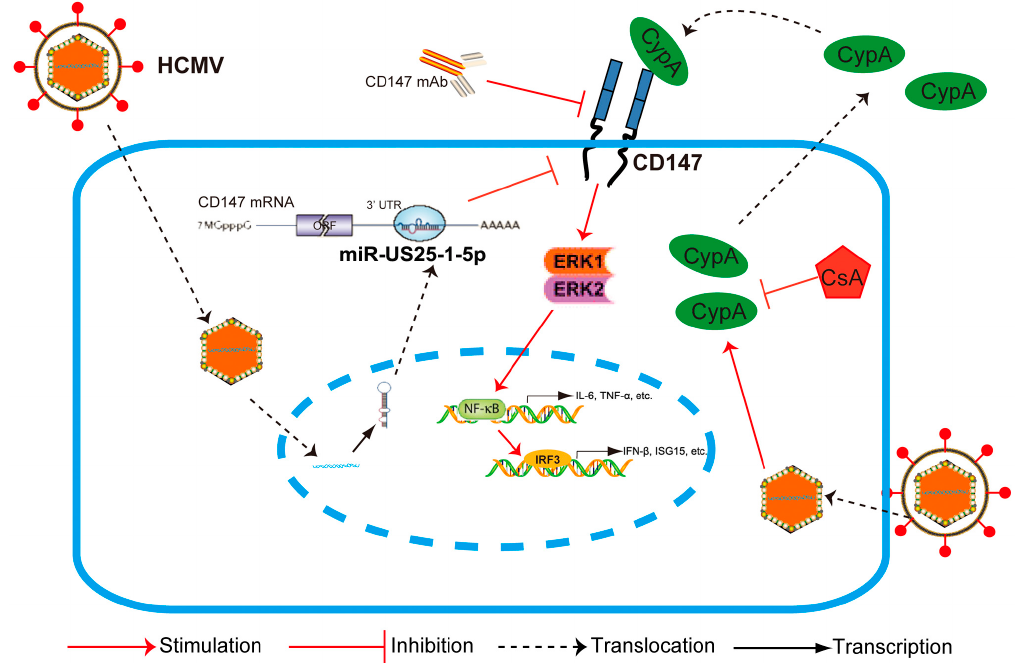
Figure 6. General model for HCMV miR-US25-1-5p in attenuating CD147/EMMPRIN-mediated HCMV-triggered early antiviral response. Upon HCMV infection, intracellular CypA is released. As a paracrine proinflammatory cytokine, CyPA interacts with CD147 of those uninfected cells and tissues, and stimulates the phosphorylation of ERK1/2. The activation of NF- κ B then occurs, followed by a subsequent activation of the IRF3 phosphorylation and the orchestrated NF- κ B-dependent, IRF3 plus NF- κ B-dependent immune responses. HCMV-encoded miR-US25-1-5p targeting CD147, CD147-blocking mAb, and an inhibitor of CyPA (CsA) can specifically inhibit this process.